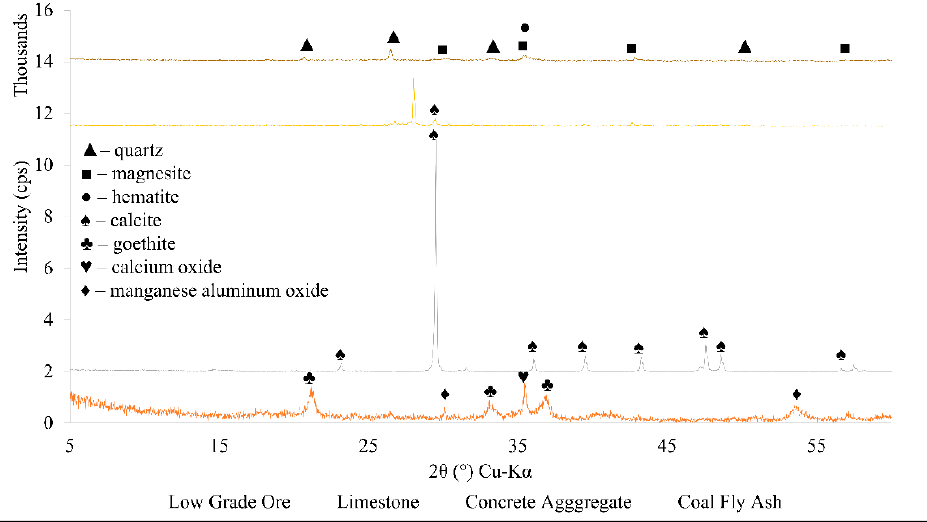
Figure 2. X-ray diffraction of raw low-grade ore, limestone, concrete aggregate, and coal fly ash. Figure 2. X-ray di ff raction of raw low-grade ore, limestone, concrete aggregate, and coal fly